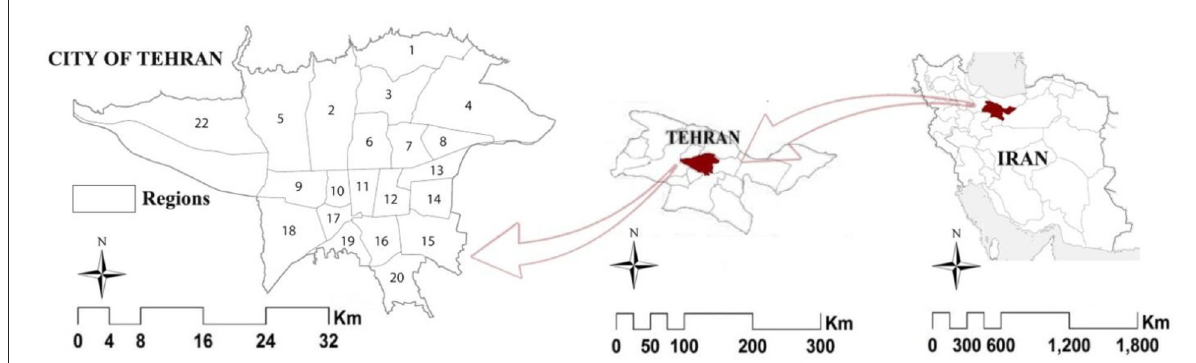
FIGURE1 Study location; from right to the left: country of Iran, Tehran Province, Tehran City and its